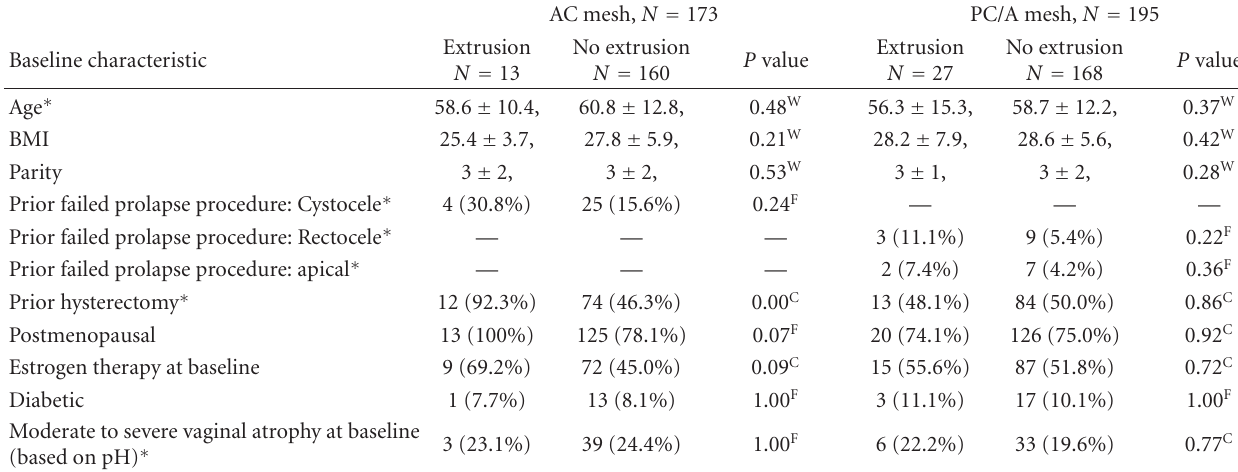
Table 1: Subject demographics.